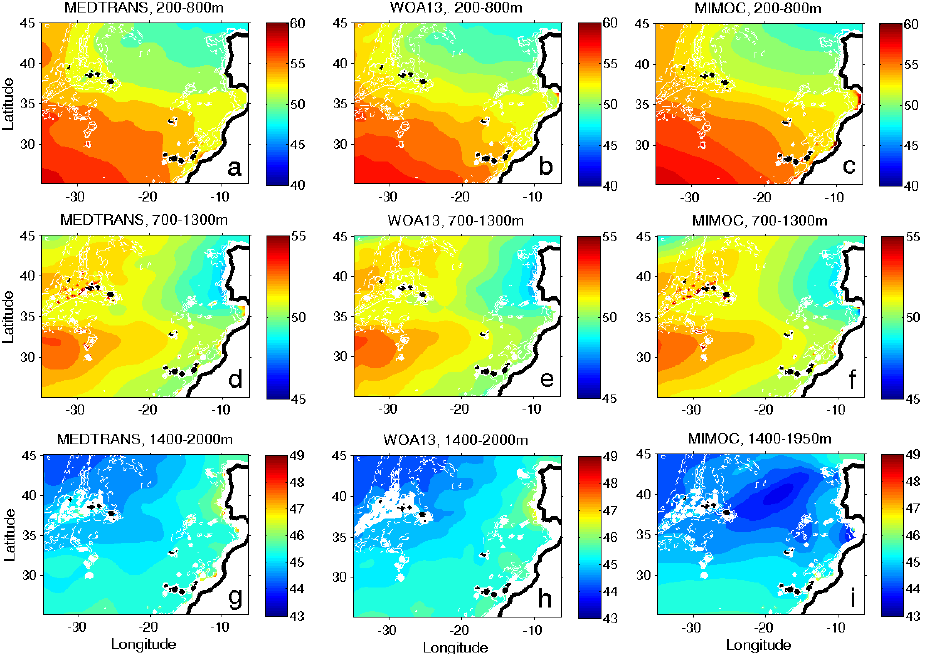
Figure 10. N 2 : (a–c) average from 200 to 800m, (d–f) average from 700 to 1300m, and (g–i) average from 1400 to 2000m, for MEDTRANS (the first column), WOA13 (the second column) and MIMOC (the third